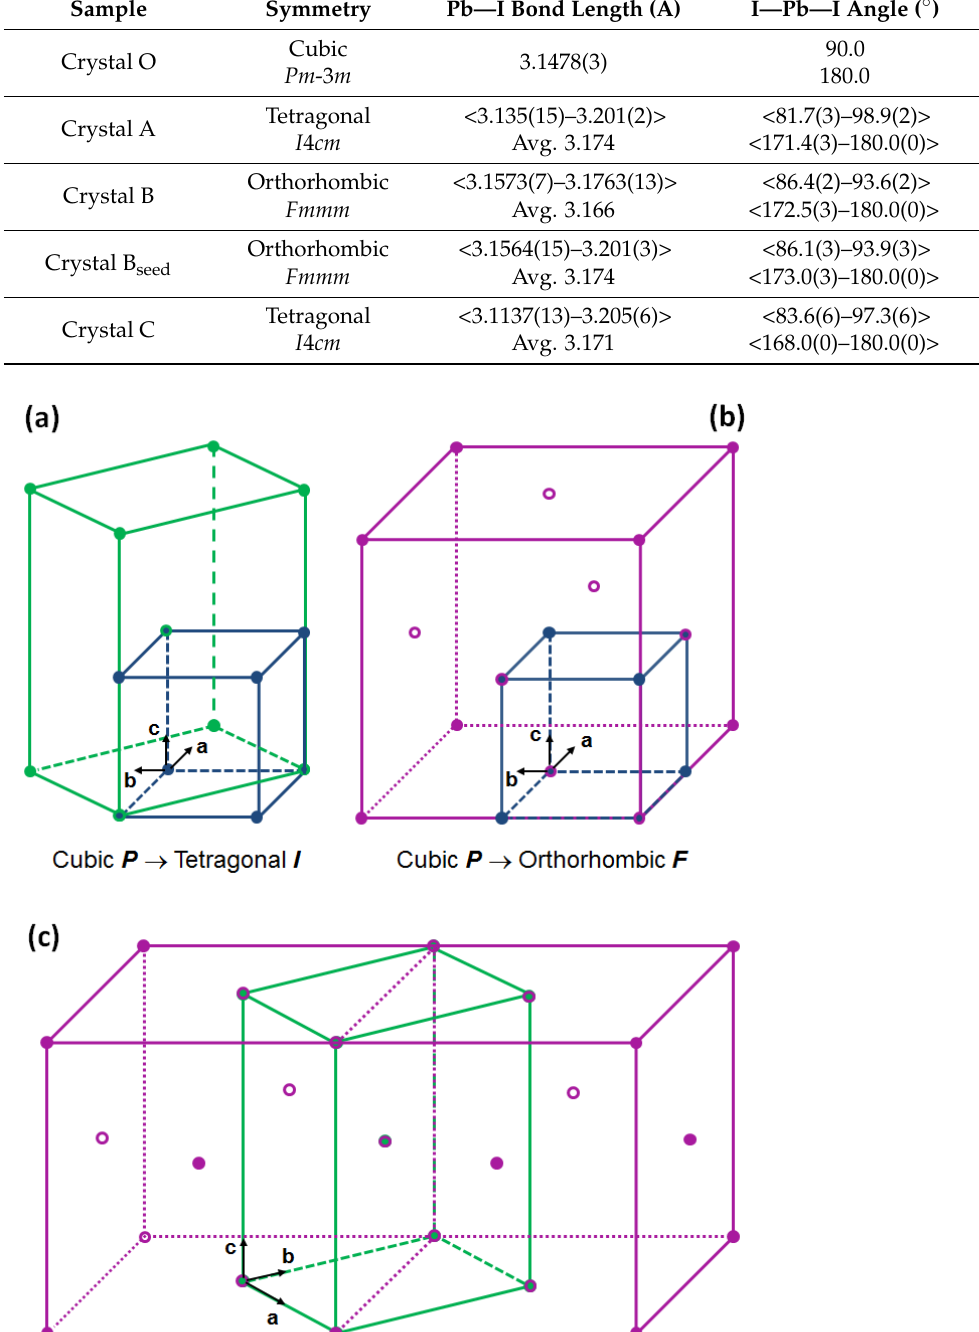
Table 2. Geometric parameters of the MAPI crystals from acid additives.